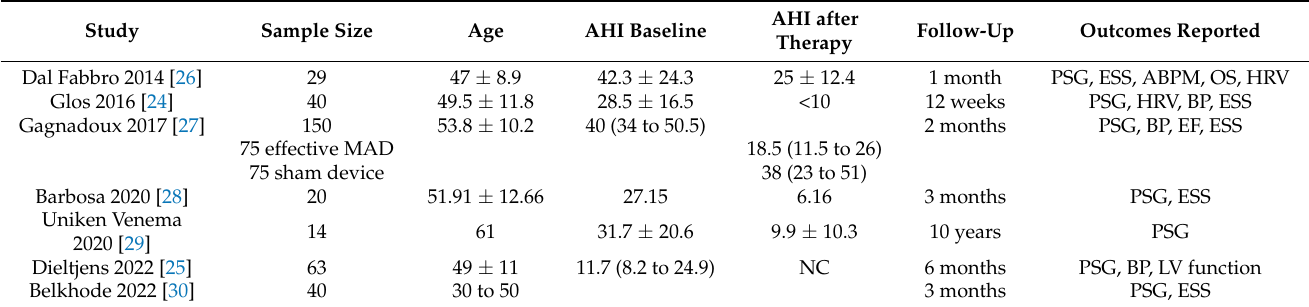
Table 1. Studies and effectiveness of MADs on the general population between 2014 and